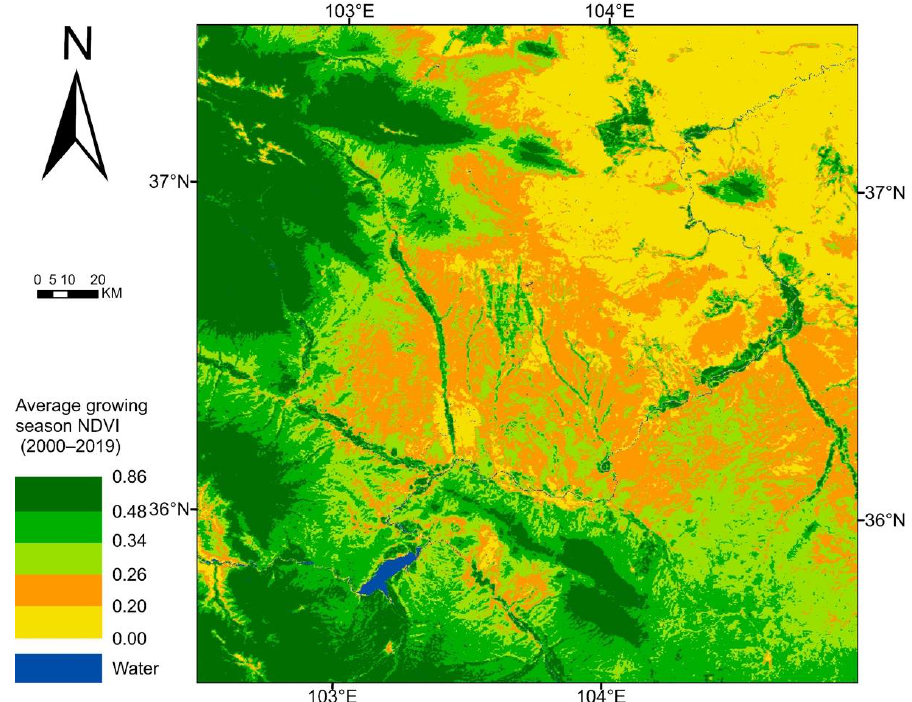
Figure 3. Average growing season Normalized Difference Vegetation Index (NDVI) for the study region during the period from 2000 to 2019. The growing season was defined as May to September. The NDVI data were obtained from the Moderate Resolution Imaging Spectroradiometer (MODIS) Collection 6 MOD13Q1 product, in which NDVI and accompanying quality assurance (QA) fields are provided. The NDVI data corrupted by clouds, aerosols, and cloud shadows were filtered out in the calculation of the growing season mean NDVI.